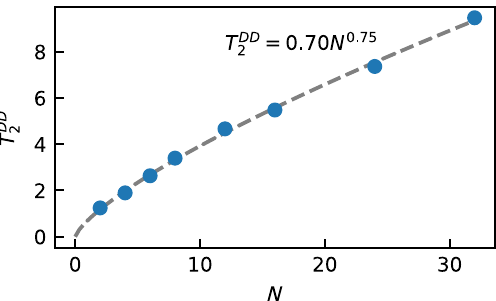
FIG. 9. Coherence time of the basal divacancy at zero magnetic field as a function of the number of decoupling pulses N .